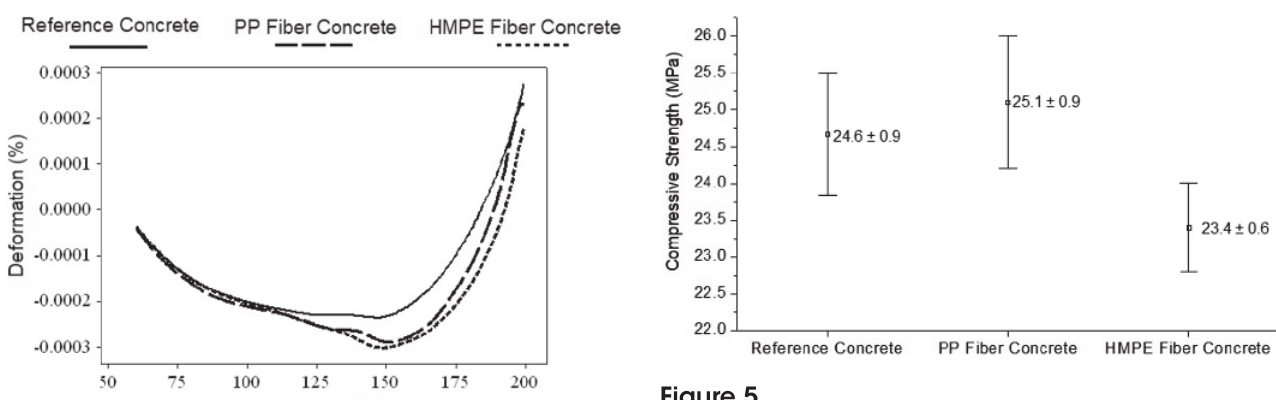
Compressive strength of the reference concrete and fiber reinforced concrete after exposure to a temperature of